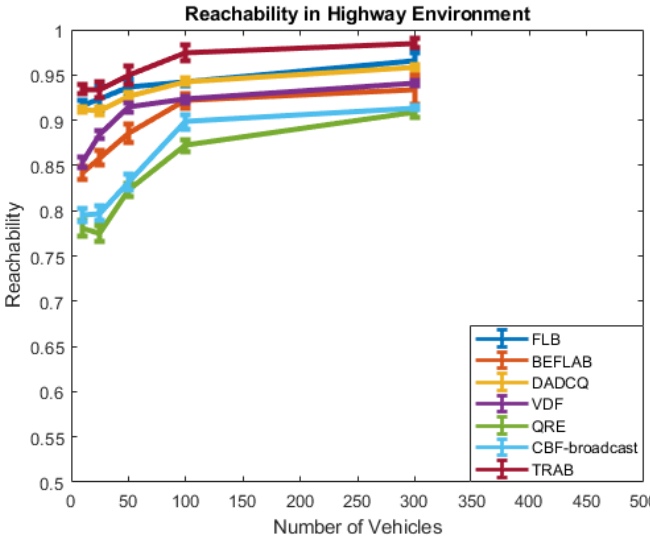
Figure 9. Highway